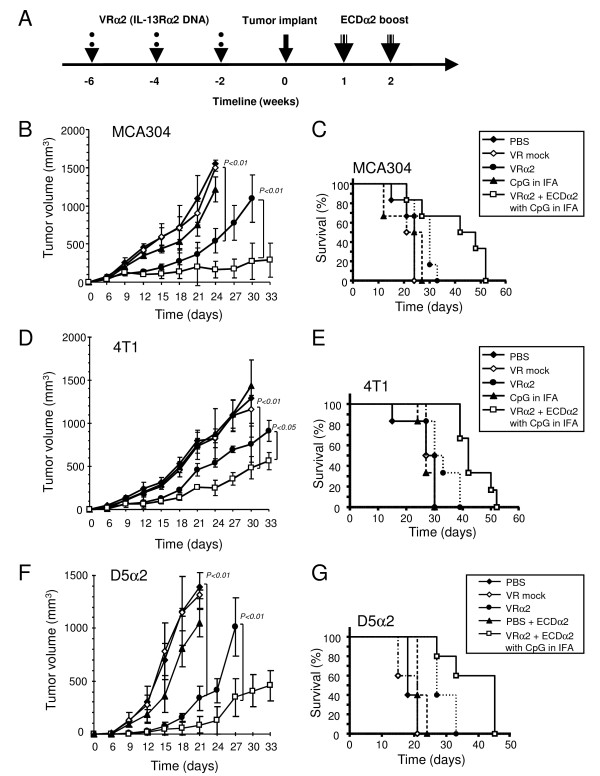
Prophylactic IL-13Rα2 DNA vaccination and post-tumor challenge boost with ECDα2. (A) prophylactic DNA vaccination of mice with MCA304, 4T1 and D5α2 tumors. Three IL-13Rα2 DNA vaccine or control vector (100 μg) were injected at two week interval before MCA304 (B and C), 4T1 (D and E), or D5α2 tumor (F and G) challenge in mice (n = 6). The ECDα2 boost vaccinations were injected on week 1 and 2. Tumor volumes were measured by Vernier caliper and Overall Sacrifice Time (OST) was calculated based on the sacrifice of mice when tumors reached to >2 cm. Experiment were repeated twice; bars, SD.